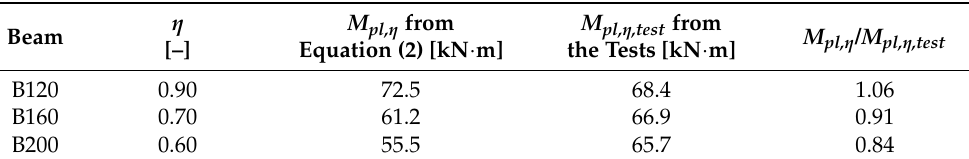
Table 5. The plastic resistance to sagging bending of the aluminium–timber composite beams with partial shear connections. partial shear connections.